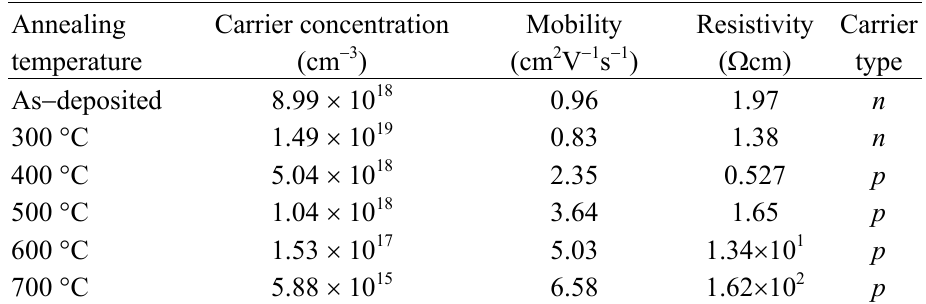
Table 3. Electrical properties of the Al–N codoped ZnO films [theoretical Al atomic ratio of 10%] deposited on silicon substrates annealed at various temperatures under nitrogen ambient for 30 min. Reprinted from Ref. [20] with permission.